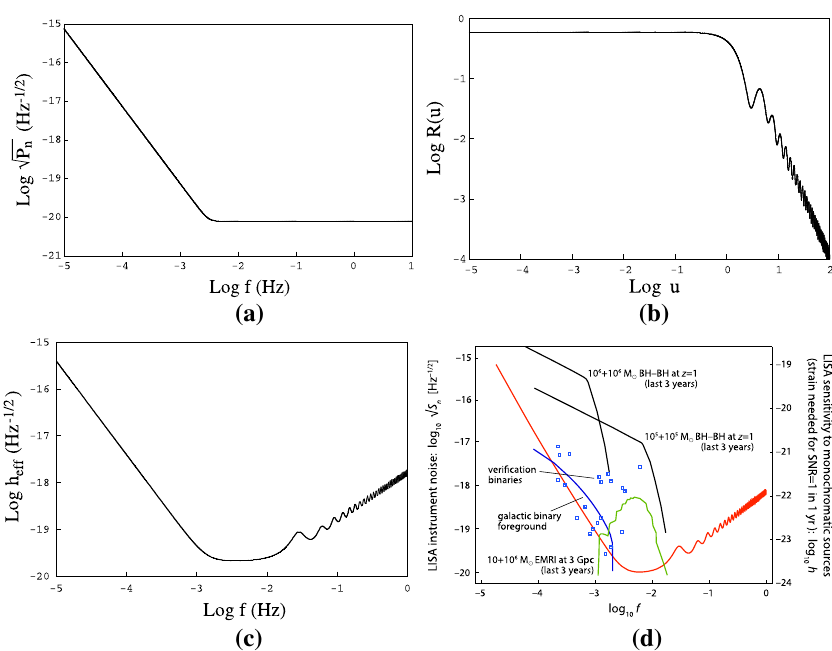
Fig. 79 Constructing a sensitivity curve for the LISA detector. Panel a shows the amplitude spectral density of the noise. Panel b shows the sky and polarization-averaged response function. Panel c shows the sensitivity curve found by dividing the noise spectral density by the response function. Panel d compares (cid:18) the filtered effective signal strength 2 f T S h ( f ) for various signals to the LISA sensitivity curve Panels a – c Image reproduced with permission from Larson et al. (2000), copyright by APS. Panel d Image provided by M.